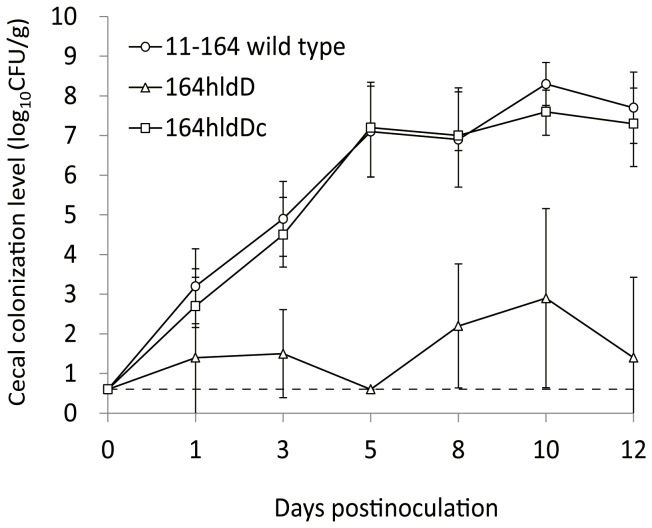
Colonization of chickens by the C. jejuni 11-164 wild-type strain and its isogenic hldD mutant.Each point represents the mean log10 CFU/g in the cecal contents of chickens in each group. Standard deviations are indicated by error bars. The dashed line indicates the lower limit of detection (0.7 log10 CFU/g).